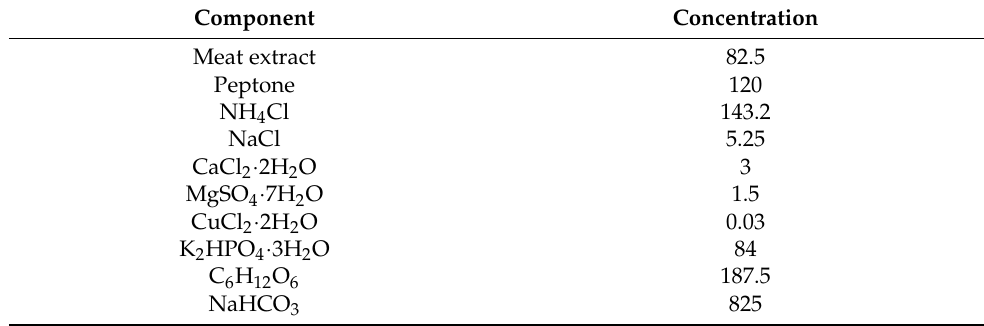
Table 1. Components of synthetic wastewater used in the study